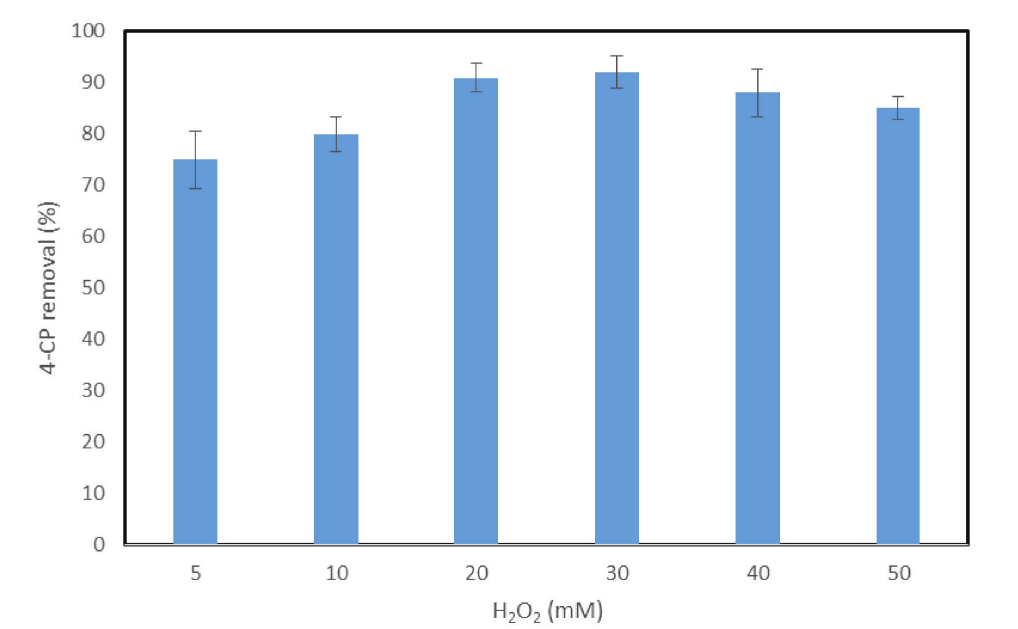
Fig. 5 – Effect of catalyst dosage on 4-CP removal (initial 4-CP concentration of 100 mg L –1 , solution pH 5, H 5 mM, and US power of 200 W)